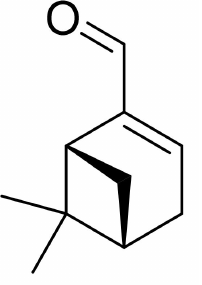
Figure 1. The structure of (-)-myrtenal.